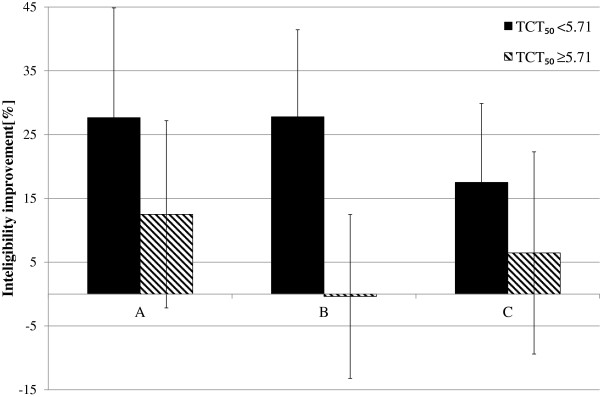
Average improvement in WER for the input speech with average rate equal to ROSmean1.